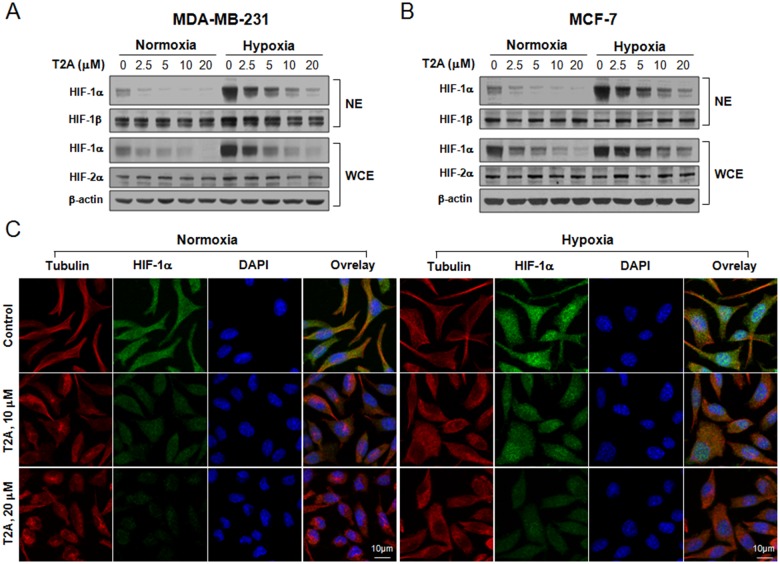
T2A inhibited HIF-1α expression in MDA-MB-231 and MCF-7 cells.(A and B) The MDA-MB-231 and MCF-7 cells were treated without or with various concentrations of T2A for 16 hours and then subjected to hypoxia, or remained in normoxia for an additional 8 hours. Whole cell extracts (WCE) and nuclear extracts (NE) were prepared from cells and subjected to Western blot assay using antibodies against HIF-1α, HIF-2α, HIF-1β, and β-actin. (C) Cells were fixed, permeabilized, and processed for immunofluorescence labeling with anti-Tubulin (Red) and anti-HIF-1α (green) antibodies. Nuclei were counterstained with 0.1 μg/ml DAPI (blue). Scale bar represents 10 μm.